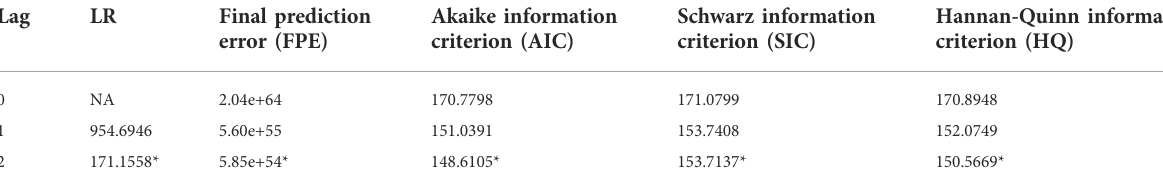
TABLE 5 Lag selection criteria.